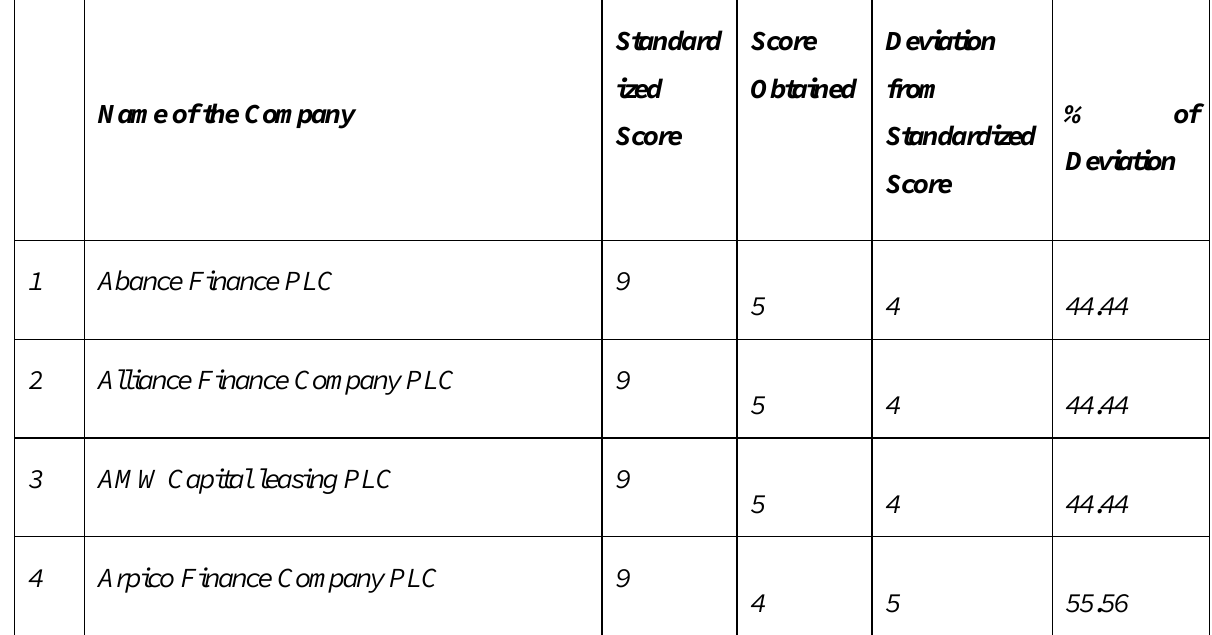
Table 07: Score Board for the compliances as per requirements of paragraph 47 Finance Lease and 56 Operating Lease of LKAS